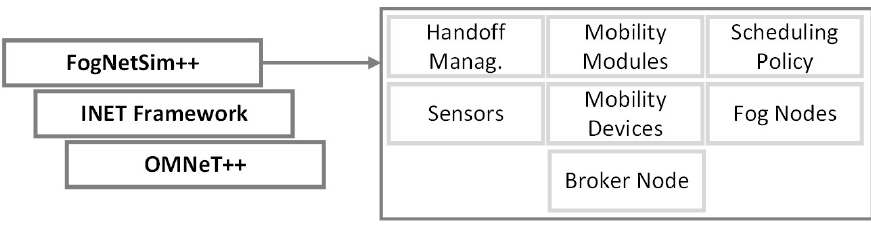
Figure 2. FogNetSim++ Architecture (Adapted from [11]).